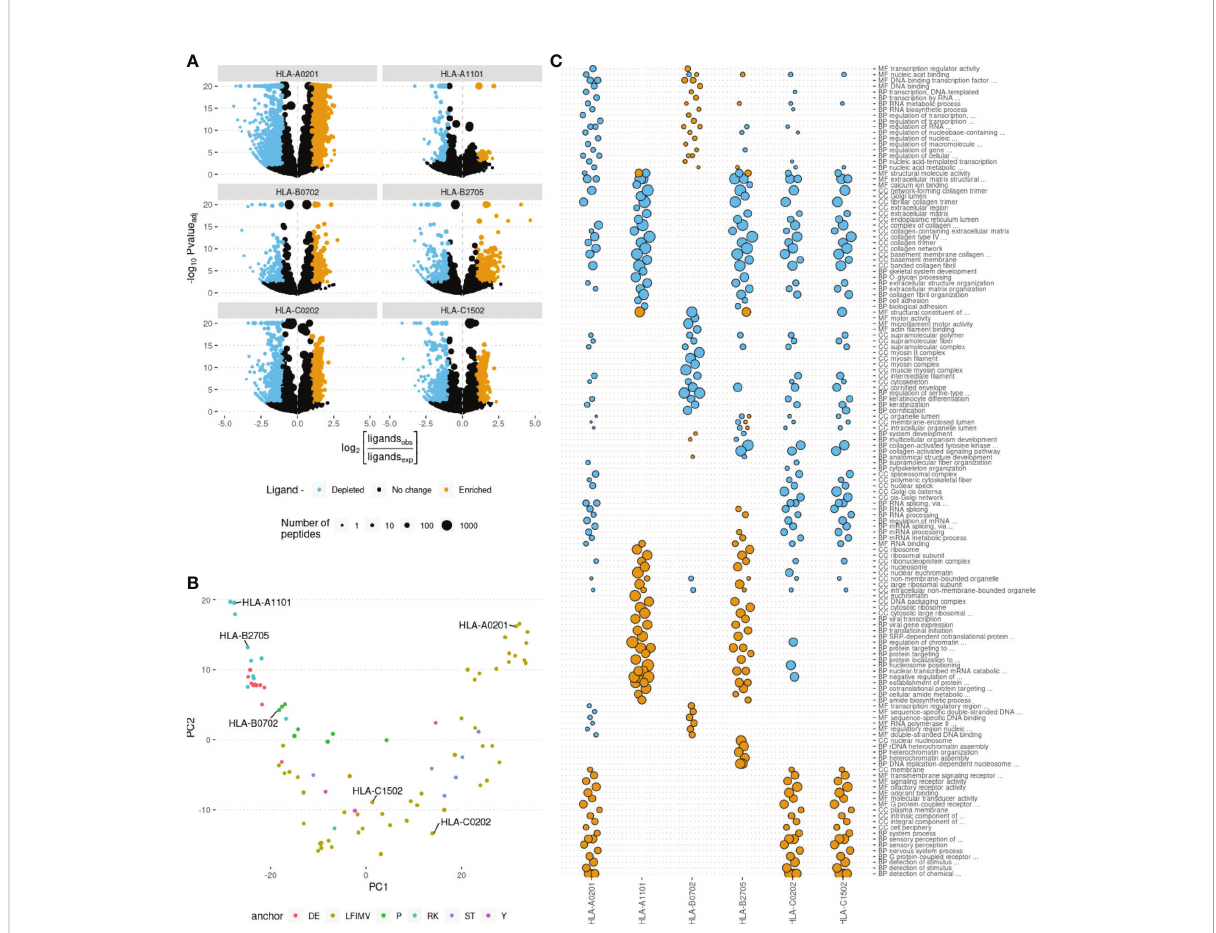
FIGURE 2 Human genes enriched and depleted in HLA ligands and their associated Gene Ontology (GO) categories. (A) Volcano plots showing the log of the ratio of observed to expected number of HLA ligands for each human gene plotted against enrichment P-value computed using binomial test. Point size shows the number of predicted HLA ligands, point color highlights genes enriched and depleted in ligands according to at least 2-fold increase or decrease in the number of ligands and adjusted P-value of < 0.05. Data for 6 selected HLA alleles are shown as separate plots. (B) Principal component analysis (PCA) of gene ontology (GO) term enrichment pro fi les. Each point represents one of 93 common HLA alleles. Colors correspond to physico-chemical properties of required anchor residues. 6 representative alleles, selected for further analysis, are marked. (C) GO term enrichment analysis for human genes differentially presented by different HLAs. Point size represents the GO enrichment fold for genes enriched (yellow) and depleted (blue) in HLA ligands for each of 6 surveyed HLA alleles. An adjusted P-value threshold of 0.01 was used as a threshold, Y axis lists the union of sets of top 20 GO categories for both ligand-enriched and ligand-depleted genes for each HLA allele. GO term names are preceded by either CC (cellular component), MF (molecular function) or BP (biological process) ontology